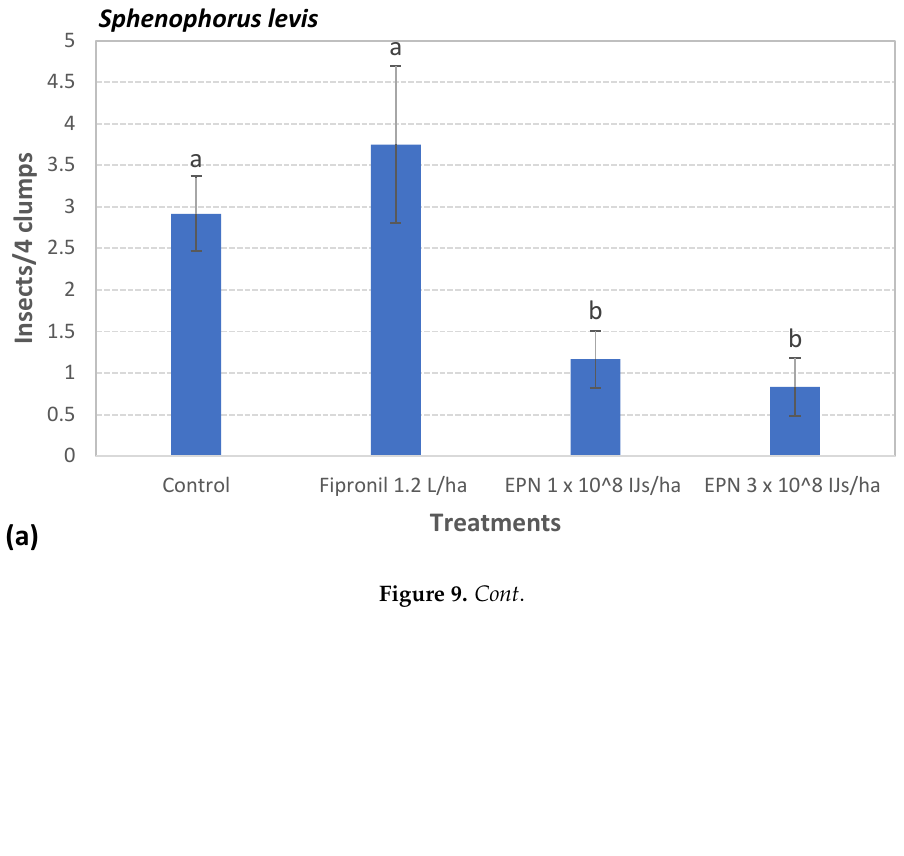
Figure 9. Population of Sphenophorus levis (larvae + pupa + adults) ( a ) and Leucothyreus alvarengai (larvae) ( b ) in a sugarcane field, 21 days after the application of Steinernema rarum (1 × 10⁸ IJs/ha and 3 × 10⁸ IJs/ha) and fipronil (1.2 L/ha). Means followed by different letters differ significantly by the Tukey test ( p < 0.005). 4. Discussion The entomopathogenic nematodes S. rarum, S. carpocapsae and H. bacteriophora caused >90% mortality of G. mellonella and S. levis larvae buried outside the rhizome, indicating that they were equally attracted and virulent to the insects. The differential results ob-